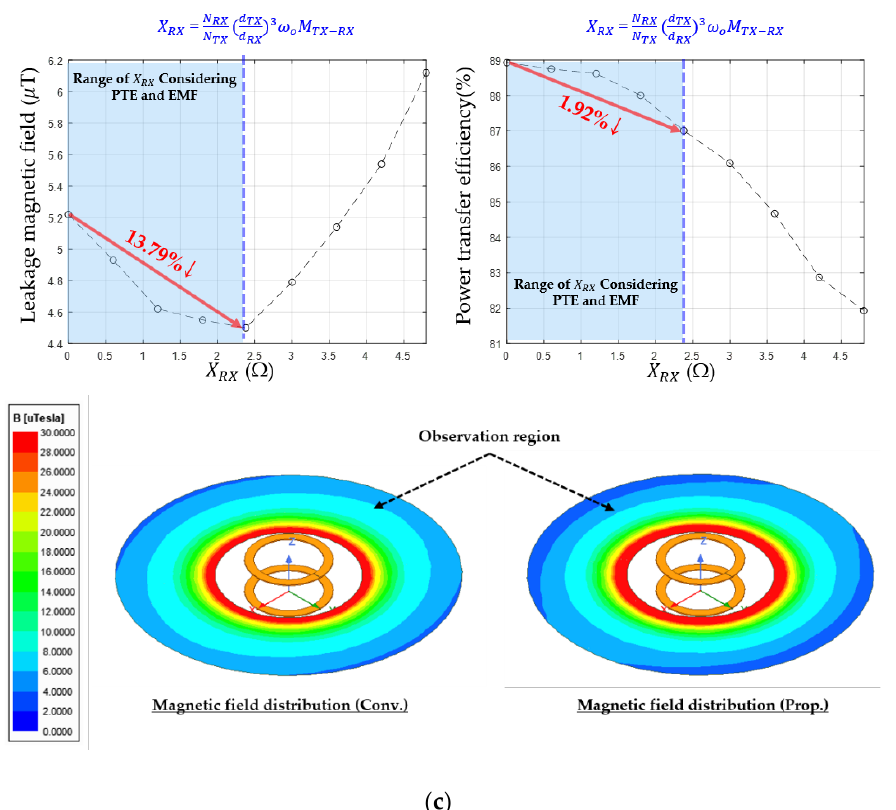
Figure 14. Simulation results (leakage magnetic field, PTE and magnetic field distribution) with variation of the air gap when the load is 3.08 Ω: ( a ) 40 mm; ( b ) 70 mm; ( c ) 100 mm.